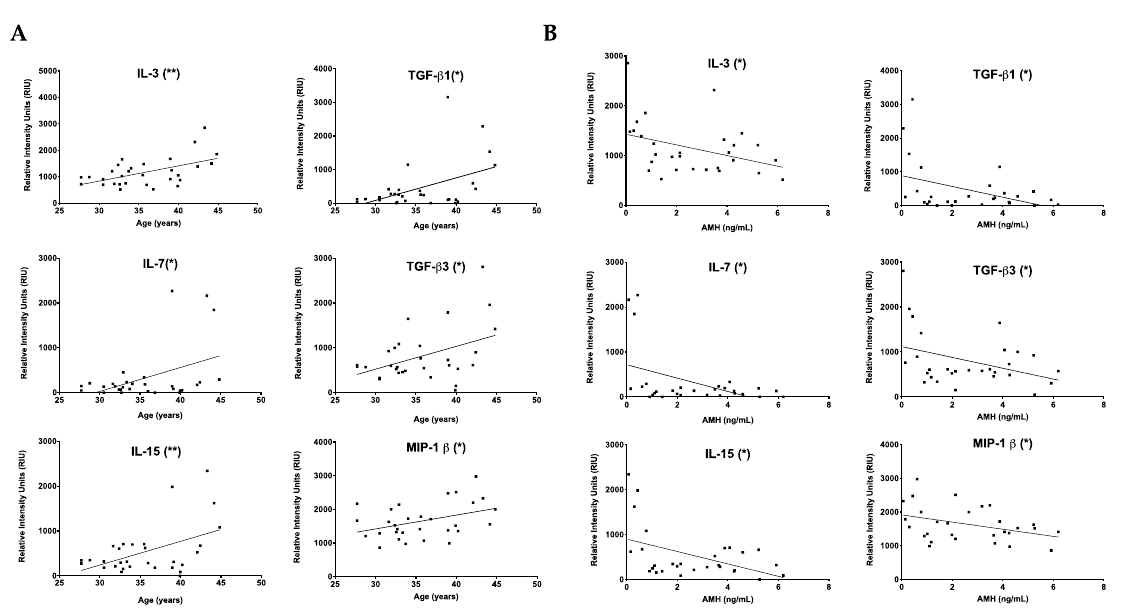
Figure 2. A unique subset of fibroinflammatory cytokines tightly associated with reproductive and chronological aging. ( A ) Graphs showing relative cytokine intensities in the follicular fluid of the first follicle in women undergoing assisted reproductive technology (ART) vs. age. Fibroinflammatory markers IL-3, IL-7, IL-15, TGF- β 1, TGF- β 3 and MIP-1 β were significantly correlated with increasing chronological age (years). ( B ) Graphs showing cytokine markers IL-3, IL-7, IL-15, TGF- β 1, TGF- β 3 and MIP-1 β were also significantly negatively correlated with anti-Müllerian hormone (ng/mL) levels, an indicator for decreased ovarian reserve. The lines correspond to the fitted regression equation. * p < 0.05, ** p < 0.01. Table 2. Relationship between fibroinflammatory cytokines and biologic and reproductive aging. Parameters